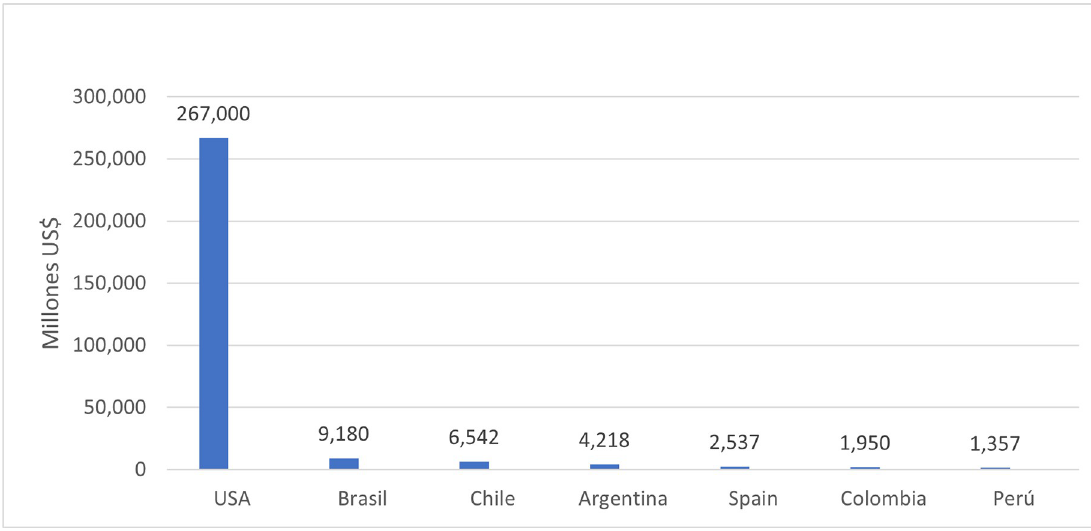
Fig 1. COVID monetary subsidty (US$). Source: Central Banks [15]. � Average of the subsidy for the first six months.